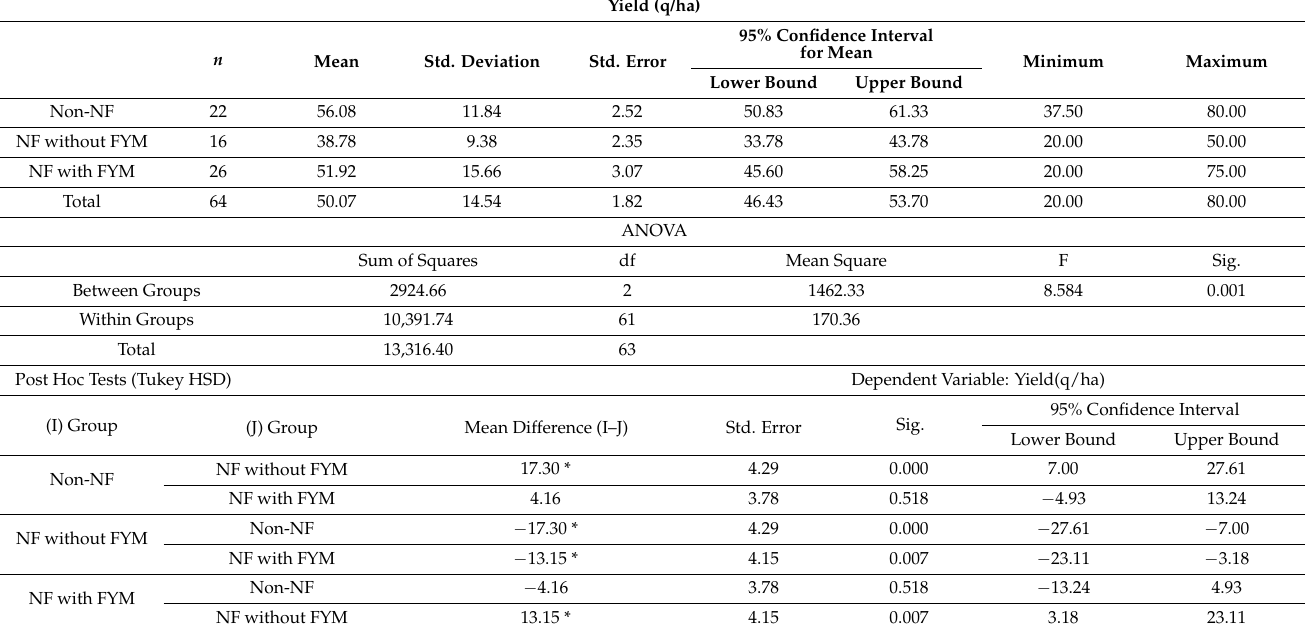
Table A2. ANOVA result of yield comparison for paddy in